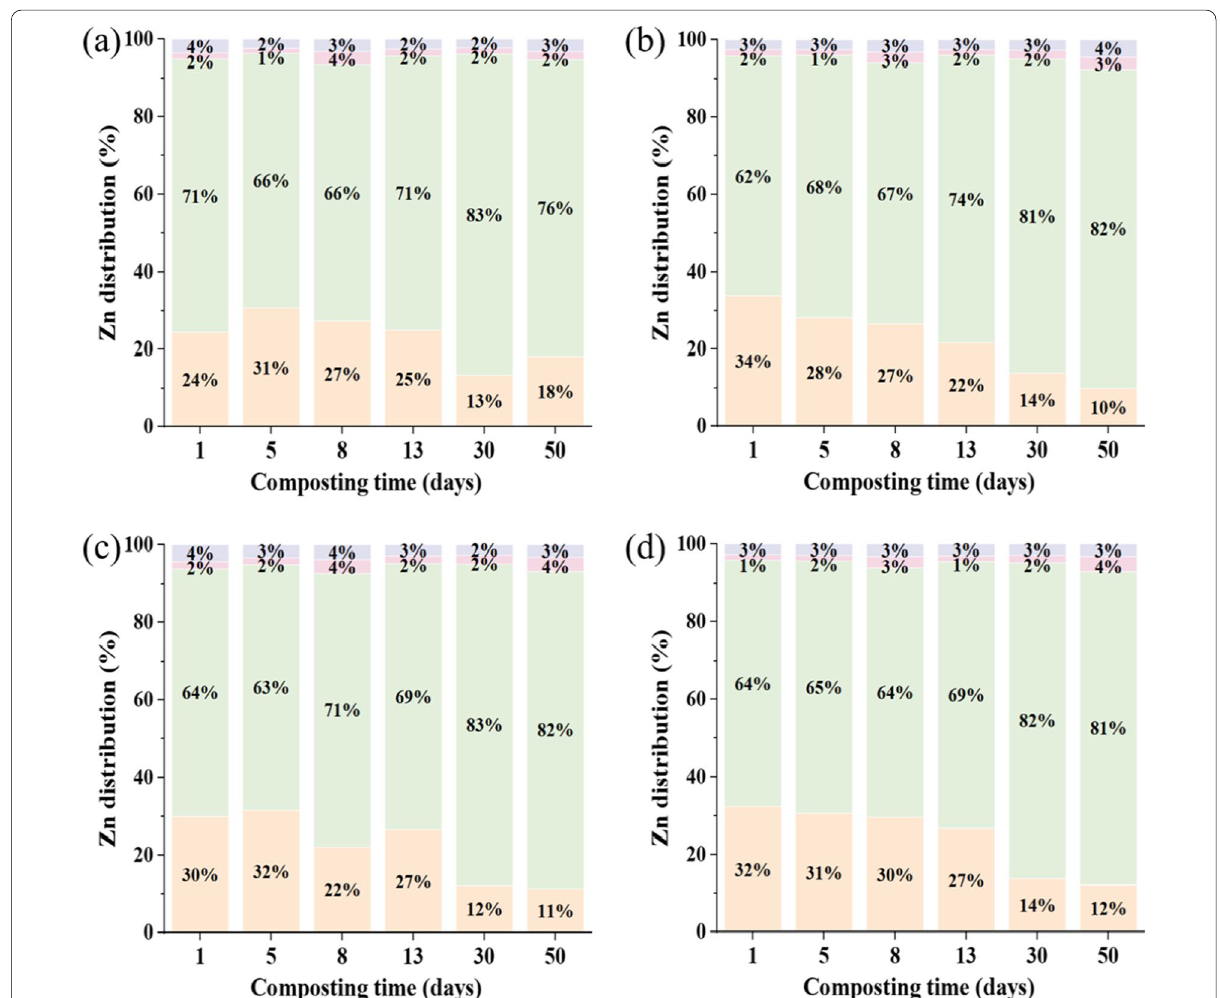
Fig. 3 Changes in Zn speciation distribution proportion of CK ( a ), BC ( b ), MB ( c ) and CB ( d ) composting. F1: acid-soluble fraction; F2: reducible fraction; F3: oxidizable fraction; F4: residual